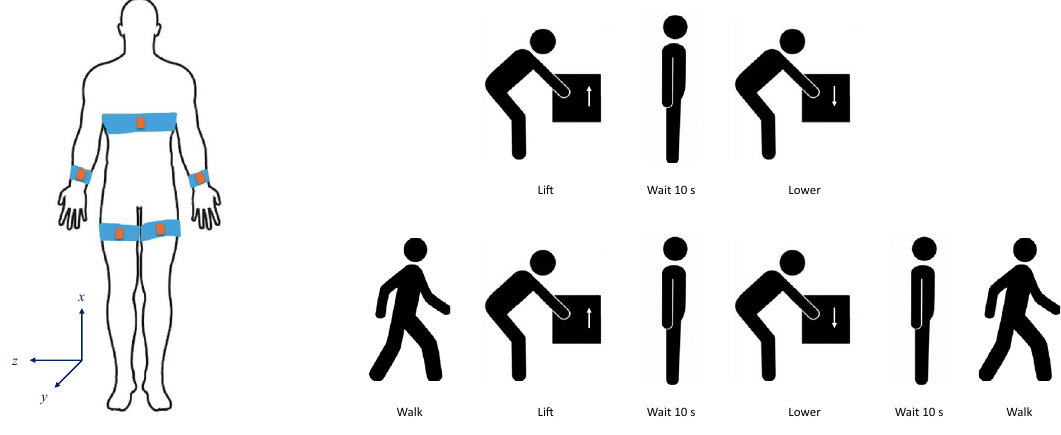
(b) Payload estimation (top panel) and HAR (bottom panel) data acquisition protocols. Figure 1. (a) IMU positioning, (b) experimental